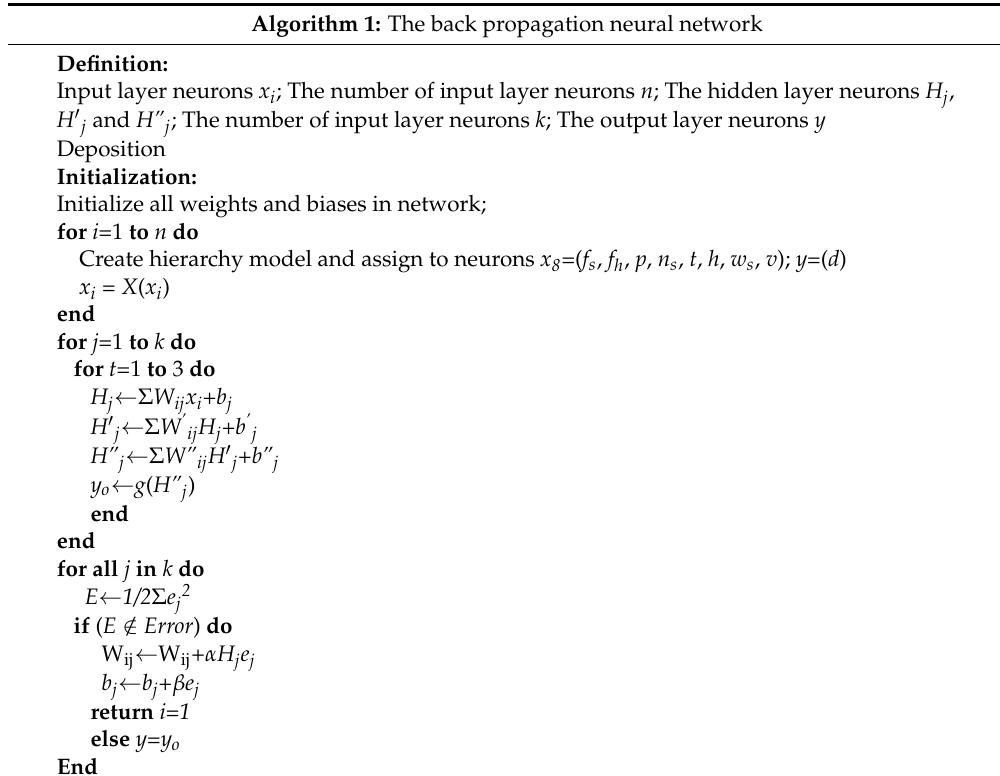
Table 1. The code of the BP neural network algorithm. Algorithm 1: The back propagation neural